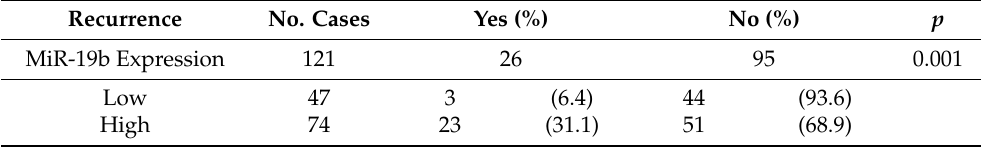
Table 3. Association between patient relapse and miR-19b expression levels in LARC